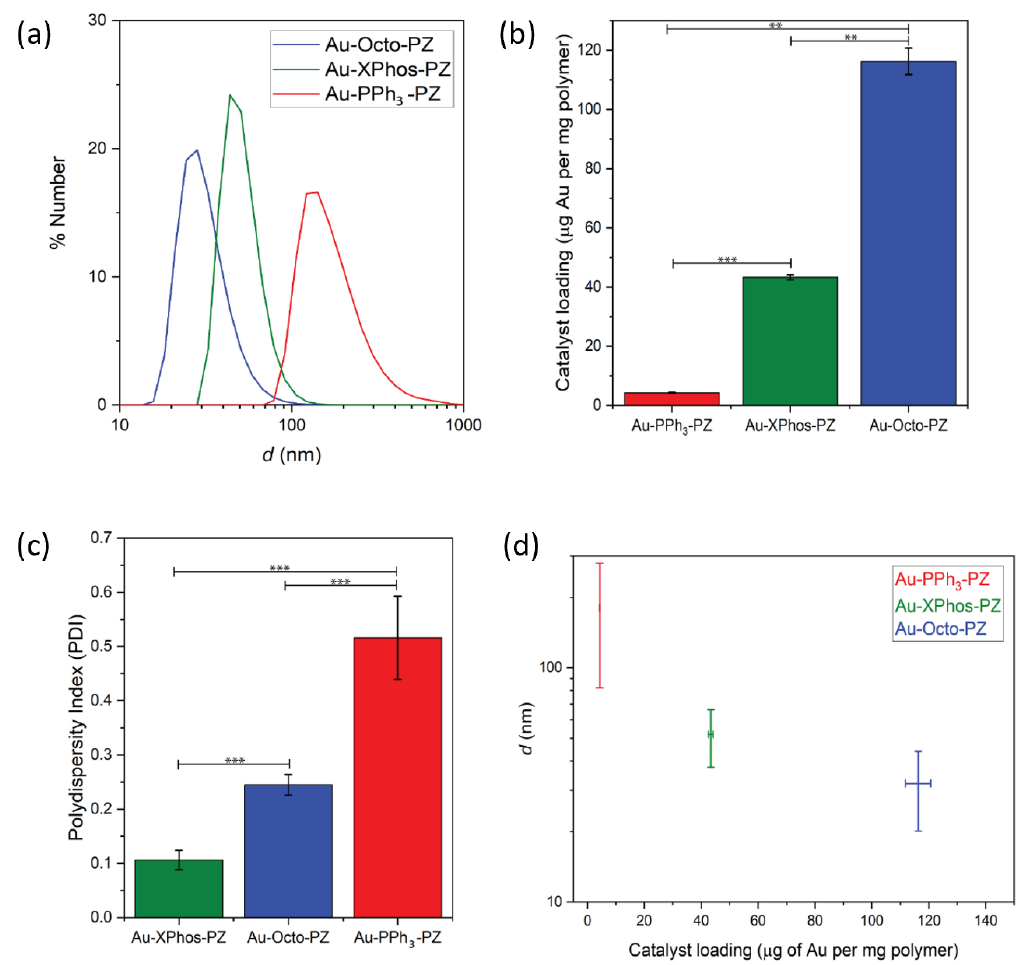
Figure 2. Characterization of the polyzymes. ( a ) Sizes of different polyzyme species were obtained via DLS measurements. ( b ) Catalyst loading was determined via ICP-MS, measuring the amount of gold present within the polyzymes and normalized to the mass of the polymer. ( c ) Polydispersity index (PDI) of polyzyme species. ( d ) Average polyzyme size versus catalyst loading. Measures were performed in triplicate, error bars represent the standard deviation. Statistical analysis was performed using Student’s t -test. ** = p < 0.05; *** = p < 0.005.